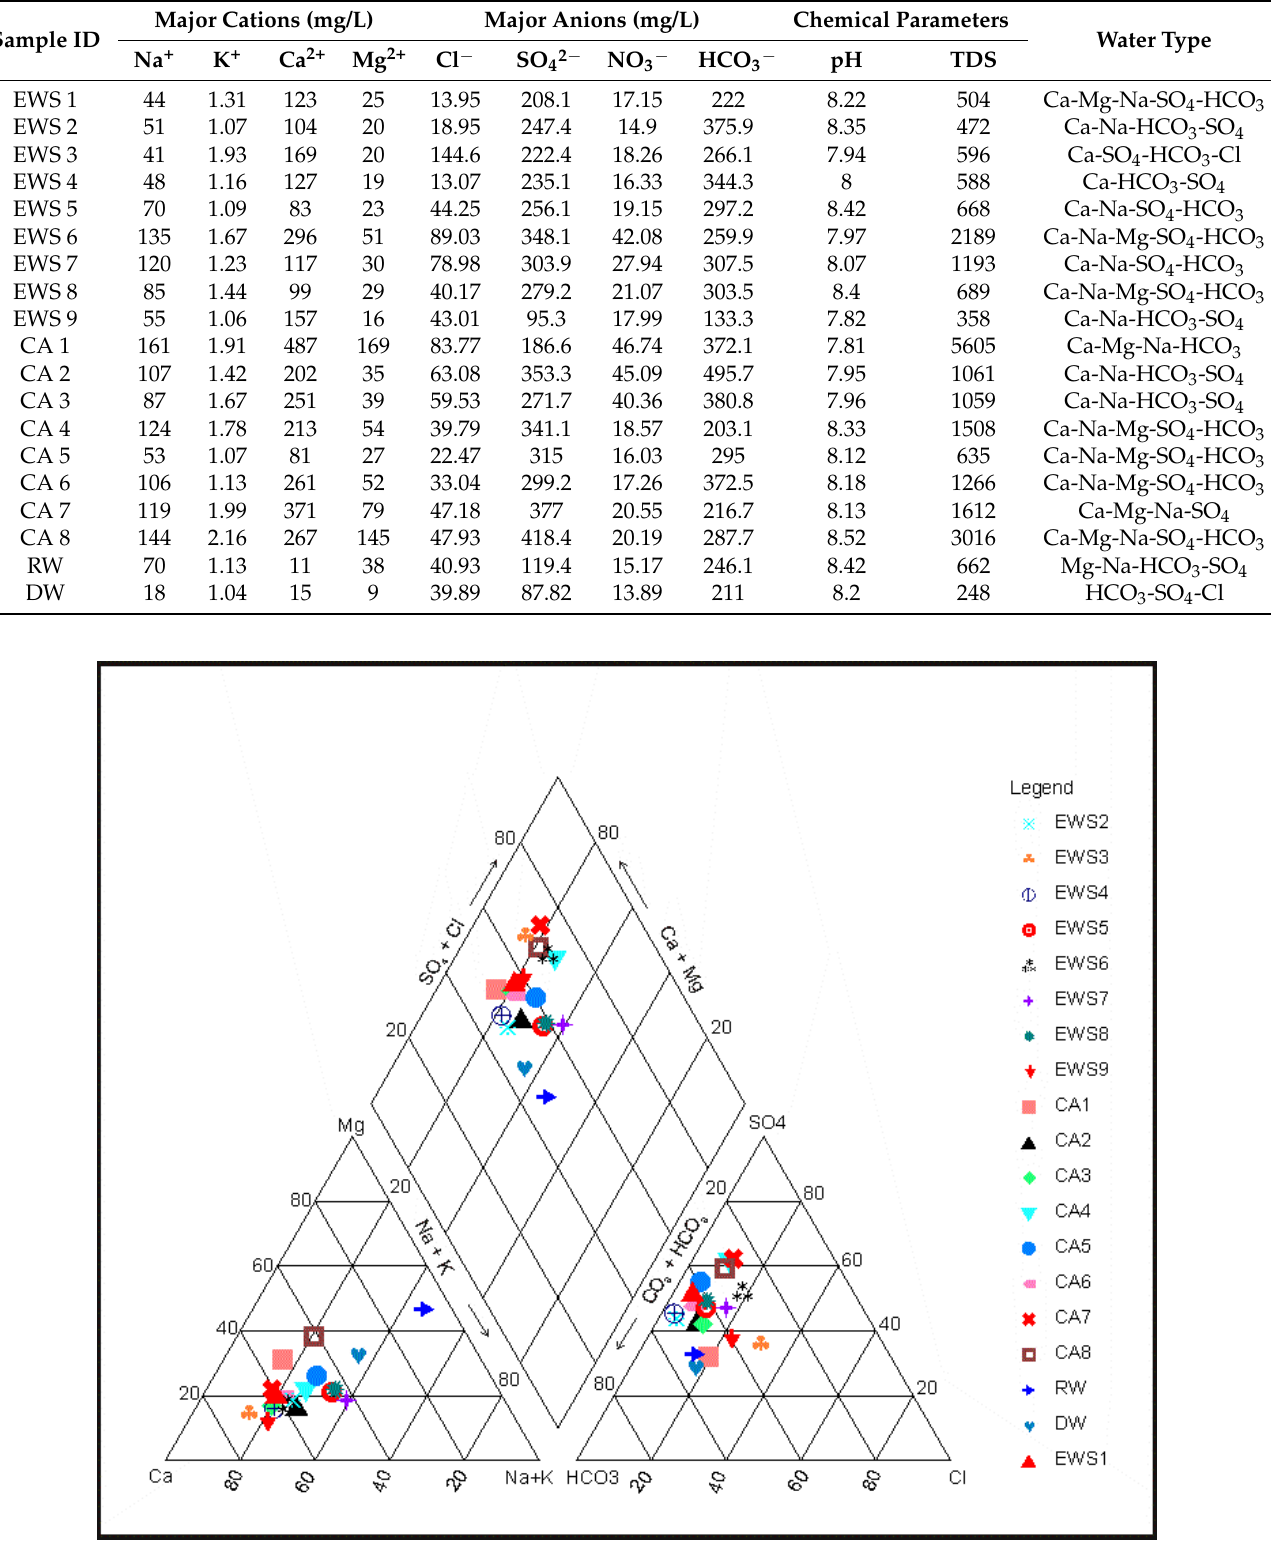
Figure 8. Piper diagram of the analyzed water samples. Table 2. The chemical analyses of the groundwater, river water, and dam water in Gumselasa catchment.